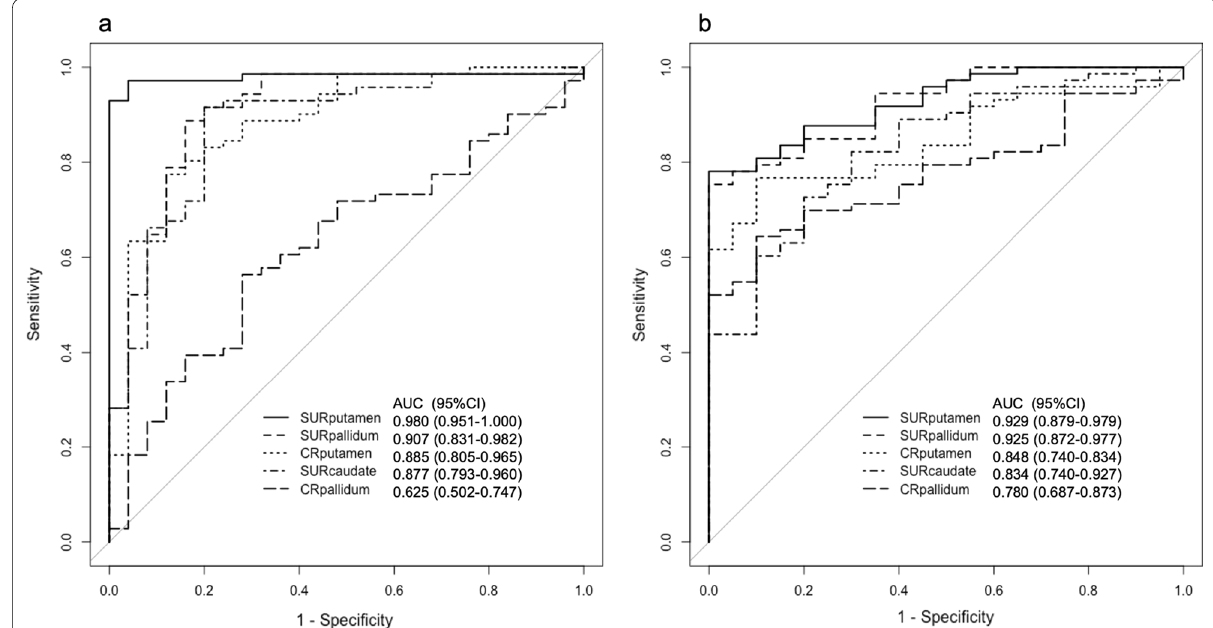
Fig. 4 Receiver operating curves for semi-quantitative indices. a The AUCs and 95% confidence interval (CI) for the test dataset 1of semi-quantitative indices in each region were SUR putamen (0.980, 0.951–1.000), SUR pallidum (0.907, 0.831–0.982), CR putamen (0.885, 0.805–0.965), SUR caudate (0.877, 0.793–0.960), and CR pallidum (0.625, 0.502–0.747). There was a significant difference between SUR putamen and other semi-quantitative indices ( P < 0.001). b The AUCs and 95% confidence interval (CI) for the test dataset 2 of semi-quantitative indices in each region were SUR putamen (0.929, 0.879–0.979), SUR pallidum (0.925, 0.872–0.977), CR putamen (0.848, 0.740–0.834), SUR caudate (0.834, 0.740–0.927), and CR pallidum (0.780, 0.687–0.873). There was a significant difference between SUR putamen and SUR caudate , ( P < 0.01), or CR pallidum ( P < 0.05). AUC area under the curve, CI confidence interval, SUR striatum uptake ratio, CR caudate ratio